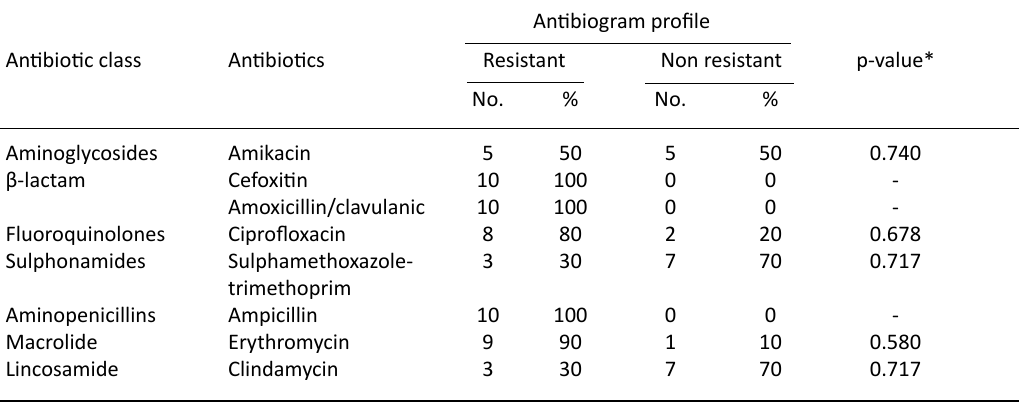
Table 1. antibiotic susceptibility pattern among MRSA